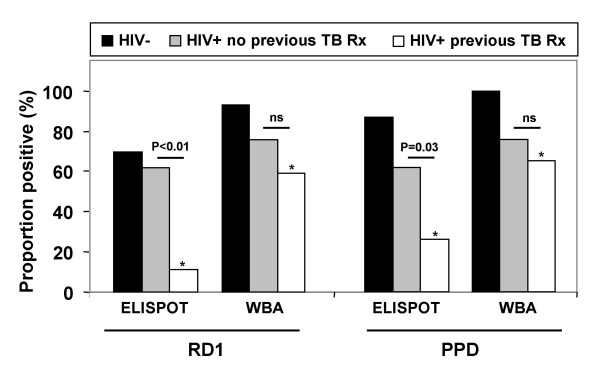
Proportion of positive IFN-γ ELISPOT responses and 7-day IFN-γ whole blood assay (WBA) responses to ESAT-6 and/or CFP-10 (RD1) and purified protein derivative (PPD) among HIV- controls (n = 30) and HIV+ patients (n = 40) subdivided into those with (n = 19) or without (n = 21) a history of previous tuberculosis treatment (TB Rx). ELISPOT assay responses in HIV+ patients were strongly associated with history of TB treatment. *In HIV+ patients who had previously received TB treatment, the proportions of positive responses to RD1 and PPD antigens were significantly lower using the ELISPOT assay than the WBA (P < 0.05 for each comparison). ns = not significant.